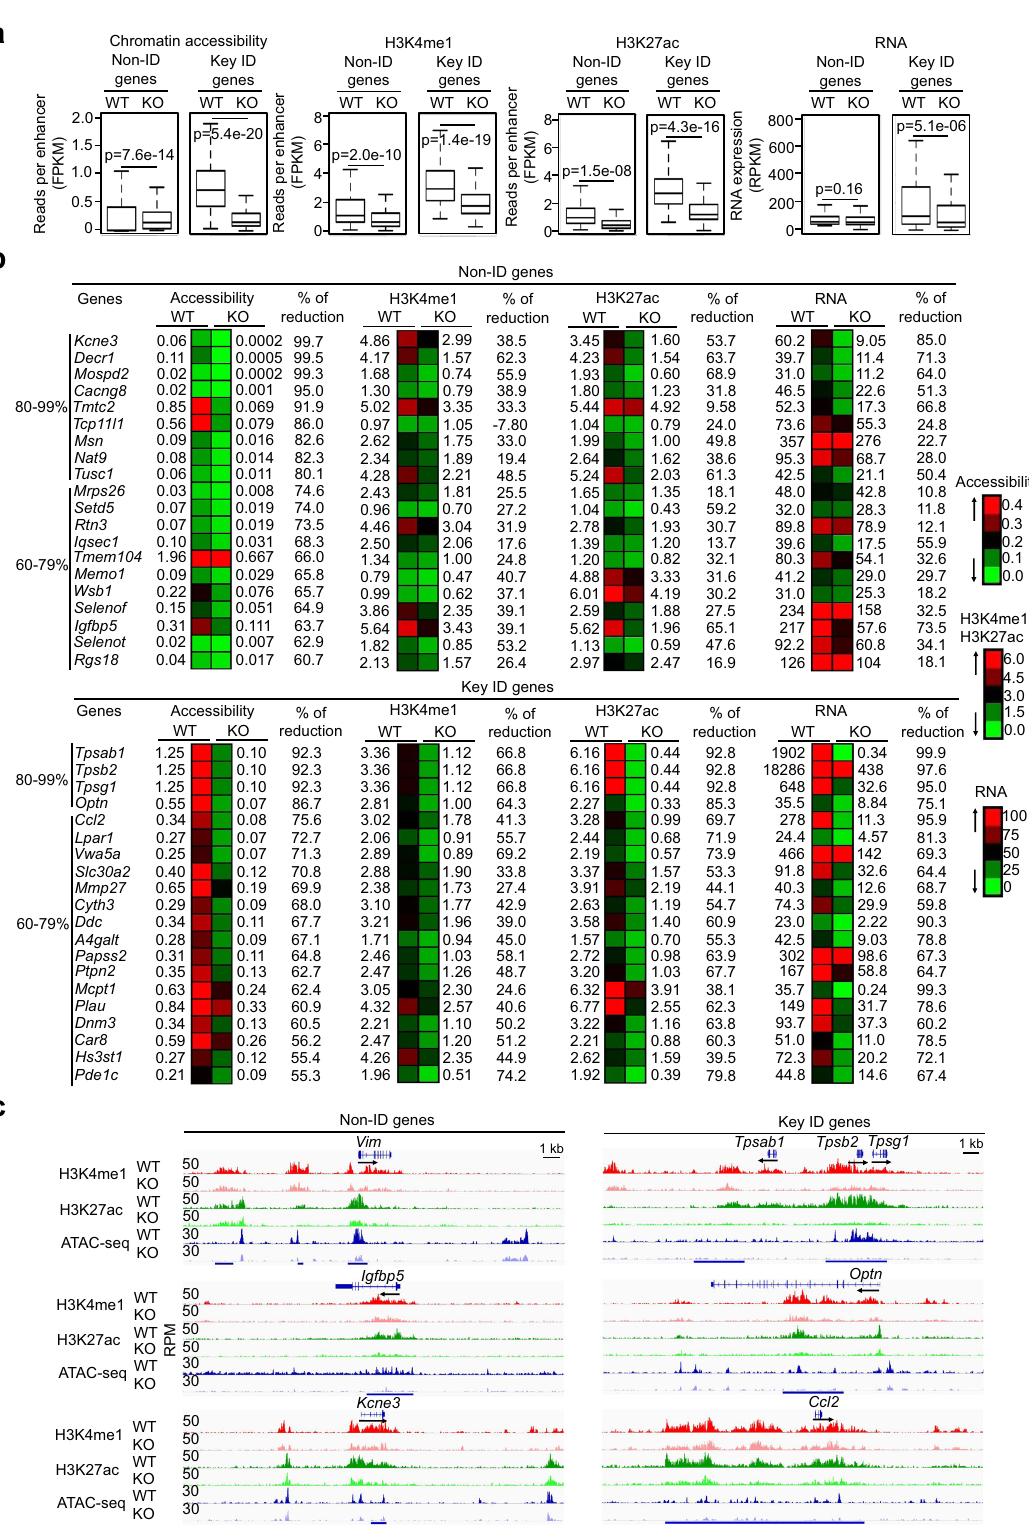
NATURE COMMUNICATIONS| (2021) 12:494